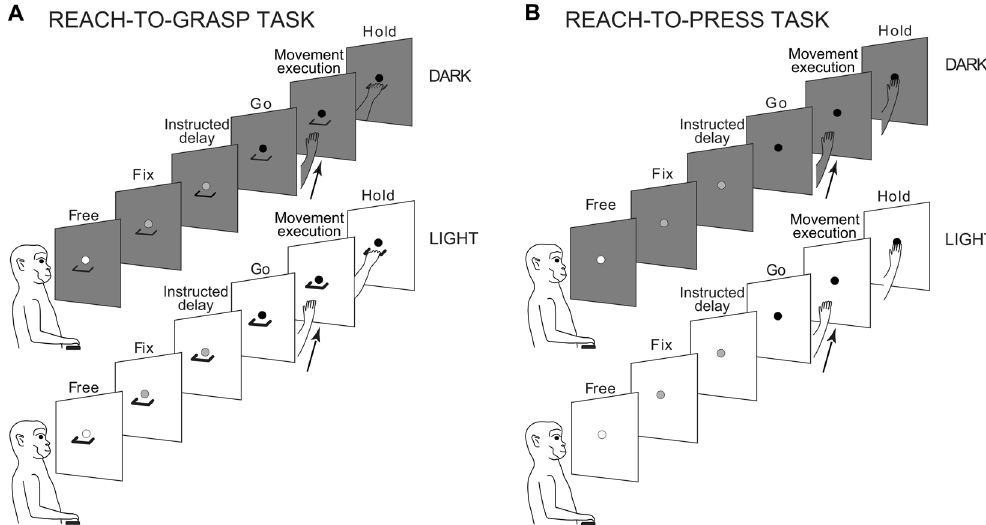
Figure 1. Behavioral tasks. ( A,B ) The figure represents the unfolding of events occurring during an example trial of the Reach-to-Grasp task ( A ) and of the Reach-to-Press task ( B ), either executed in the dark (upper panels) or in a light background (lower panels). For both tasks, each panel in the sequence corresponds to different events in the trial, as referred to by a specific label (see Methods for a detailed description of the tasks). In brief, each trial sequence began when the monkey pressed a home-button placed outside its field of view; after button press, the animal awaited instructions while still being free to move the eyes (FREE). After 0.5–1 s, a green fixation LED lit up and the monkey was required to fixate it (FIX) and to maintain fixation thereafter. After a variable delay period (1–2.5 s; INSTRUCTED-DELAY), the LED color changed from green to red (GO); this GO signal instructed the monkey to perform either a reach-to-press or a reach-to-grasp movement (MOVEMENT EXECUTION). The monkey was then asked to maintain its arm/hand in targeted position (HOLD) until the red LED switched off again, instructing the monkey to press again the home-button in order to obtain a liquid reward for correct performance and to then start a new trial sequence. Note that the last part of the instructed-delay phase, defined as the DELAY epoch, and an epoch comprising movement execution, defined as MOV epoch, were considered as the critical epochs of interest in the analyses, as detailed in the